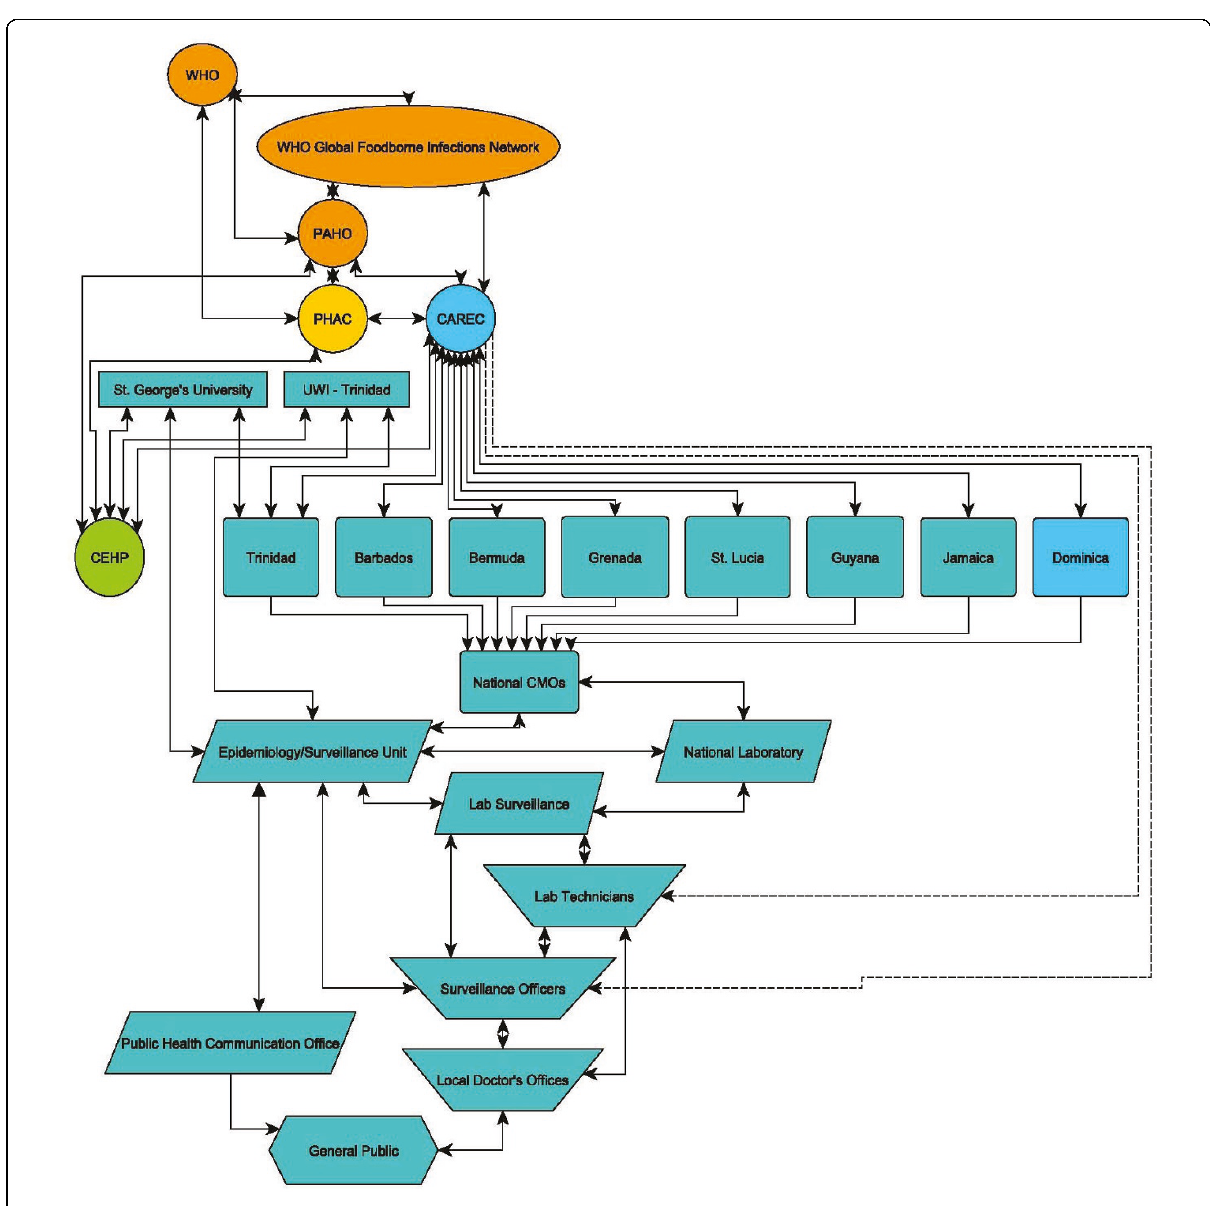
Figure 2 Overview of stakeholders involved in the Burden Of Illness research